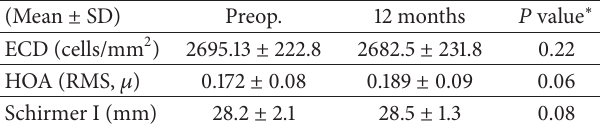
Table 4: ECD, higher order aberrations (HOA) at 6mm pupil size and Schirmer 1 scores after SMILE Xtra ( 𝑛 = 40